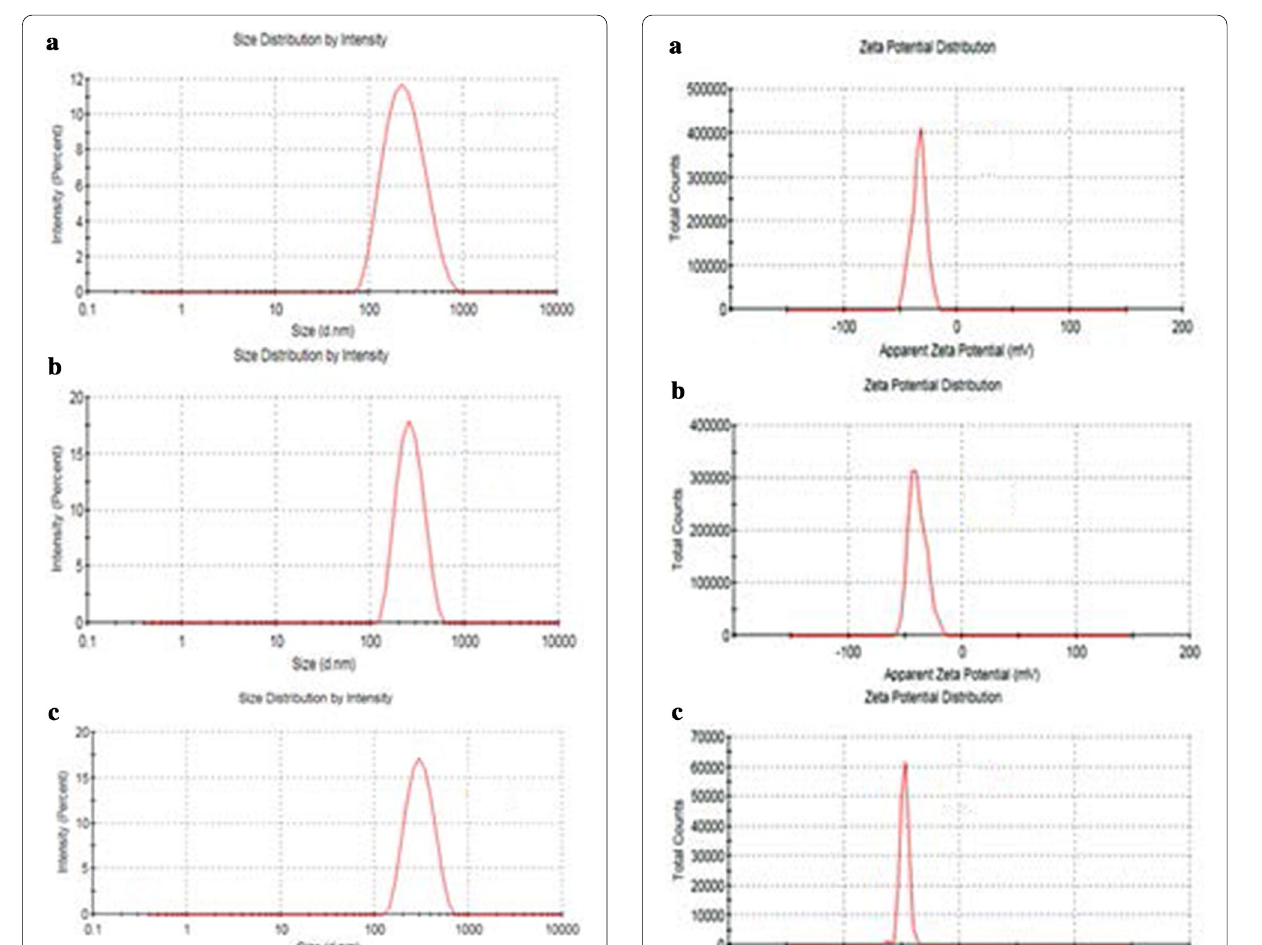
–COOH in Tau-GO and –F in 5-FU, these hydrogen bonds make 5-FU-Tau-GO stable in solution. The in vitro cumulative release of 5-FU from the 5-FU- Tau-GO, at the temperature of 37 °C in pH 1.2, 6.5 and 7.4 PBS solution (simulate gastric environment, liver cancer cell environment and physiological environ- ment, respectively) is shown in Fig. 10. It is found that the 5-FU released behavior was affected by the pH value of the environment. In a pH 7.4 buffer, the drug release was slow and continuous, and the total released amount of drug was approximately 70.84% after 72 h. In contrast, the released amount of drug at pH 7.4 was significantly lower than that at pH 1.2 and pH 6.5 at the same time point. The total drug loading that was released from the 5-FU-Tau-GO could be achieved at approximatively 90.29% and 85.75% and at pH 1.2 and pH 6.5, respec- tively. It can be attributed to the π-π interactions and